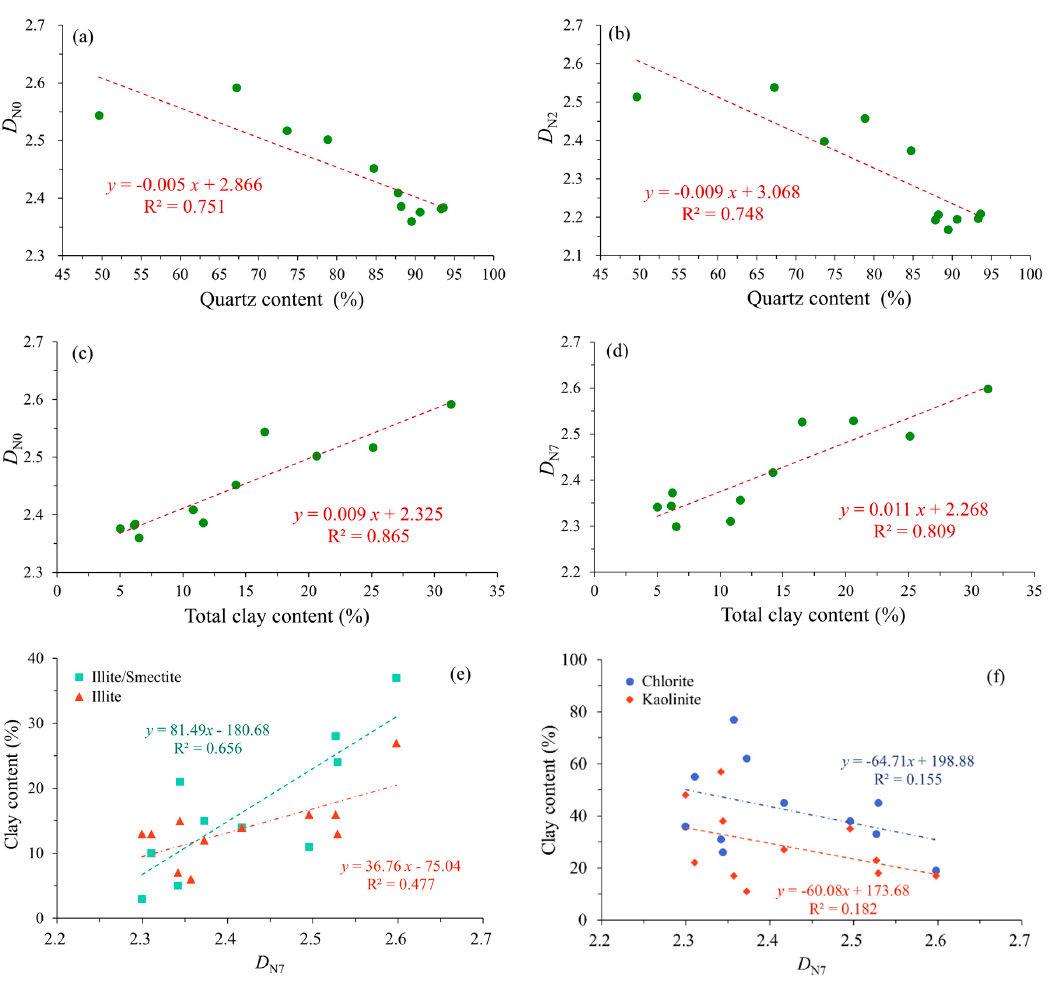
Figure 11. The e ff ect of mineral content on fractal dimensions. ( a ) The relationship between quartz content and D N0 ; ( b ) the relationship between quartz content and D N2 ; ( c ) the relationship between total clay content and D N0 ; ( d ) the relationship between total clay content and D N7 ; ( e ) the relationship between illite / smectite and illite with D N7 ; ( f ) the relationship between chlorite and kaolinite with D N7 .